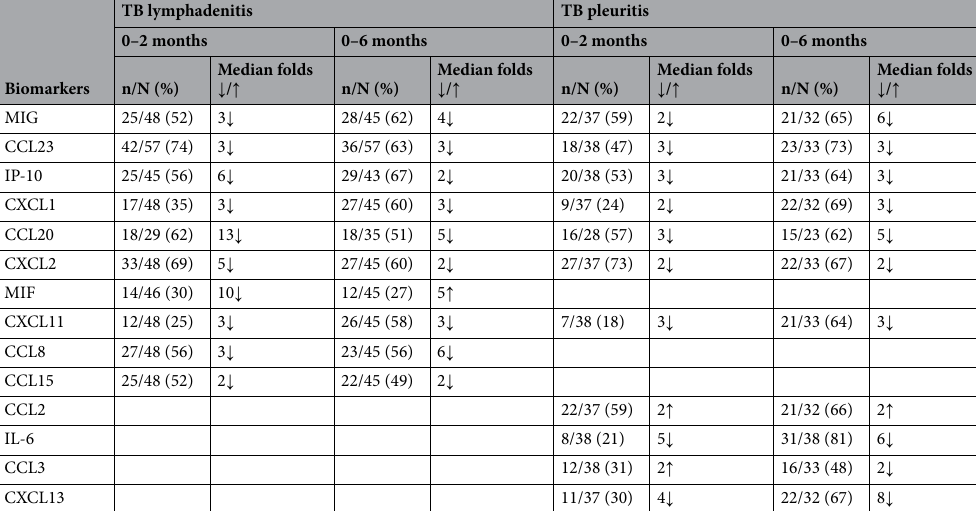
Table 2. Proportion of tuberculous (TB) pleuritis and TB lymphadenitis showing a change of > 20% in the levels of biomarkers in response to treatment and the magnitude of fold increase or decrease in the median levels. The biomarkers were detected from the dried blood spots. N total number of patients, n number of patients showing > 20% change, Folds ↓ / ↑ : fold decrease or